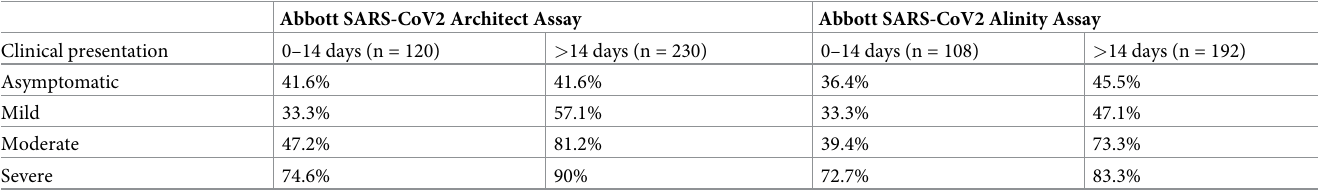
Table 4. Assay performance compared with RT-qPCR delineated by reported clinical